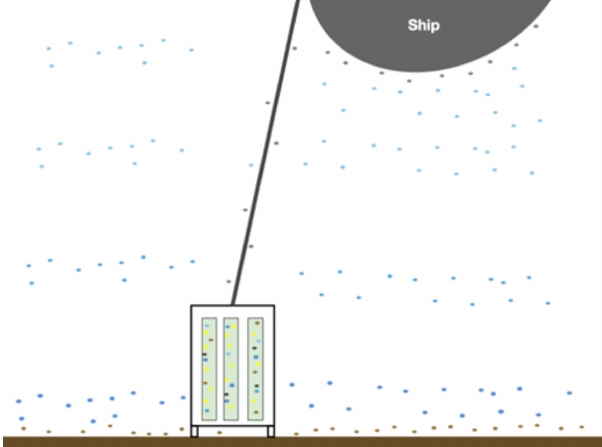
Figure 2. Illustration of various microbial communities present in the sampling environment. The different colored dots represent mi- crobes from varying depth ranges in the water column (shades of blue) as well as microbes surrounding the ship, drill, and drill line (grey), microbes at the water–sediment interface, and the actual sub- surface microbes (yellow) that live in the rock cores. The blue, grey, and brown dots represent the potential for contamination to the sub- surface rock cores and illustrate the need for rigorous contamination